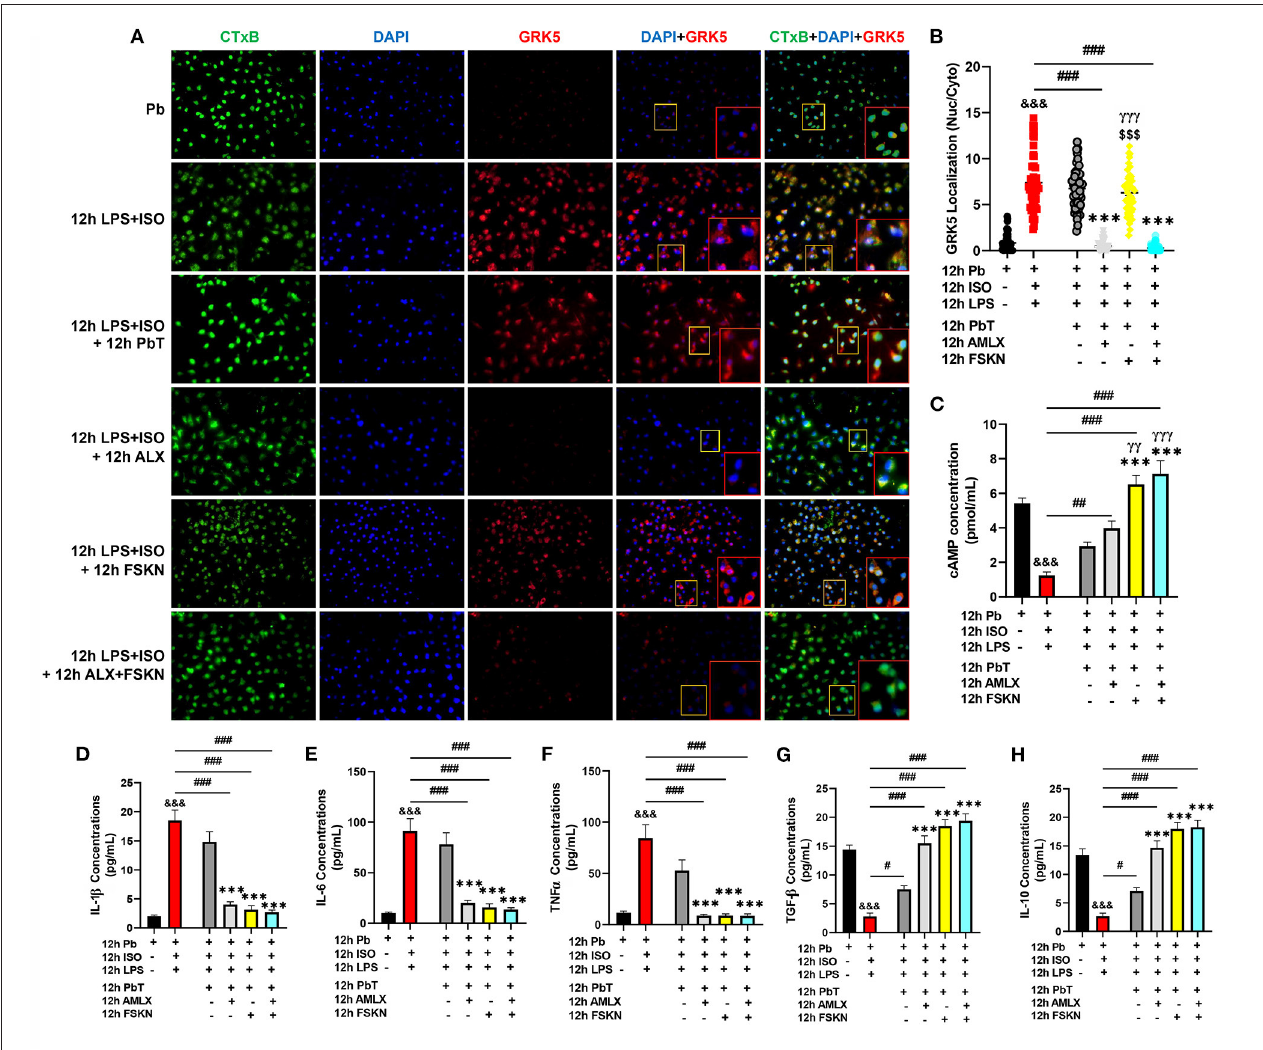
FIGURE 5 | Amlexanox and Forskolin inhibits hyperactive proinflammatory responses via G protein-coupled receptor kinase 5 (GRK5) inhibition and synergistic upregulation of cyclic adenosine monophosphate (cAMP). (A) Representative immunofluorescence of GRK5 localizations, cytoplasmic membrane (CTxB), and nuclei (DAPI). (B) The plotted values are the GRK5 (nuclear/cytoplasm) expression ratios assessed from each PM 8 ( n = 12–15 cells per 4 mice per group). Color channels were adjusted in the merged images to enhance the visualization of all the respective fluorescence dyes. (C) Graphical plots of evaluated cAMP concentrations to assess the effect of the treatment interventions cAMP bioavailability. (D–F) Graphical plots of ELISA evaluated proinflammatory cytokines (IL-1 β , IL-6, and TNF α ) concentrations. (G,H) Graphical presentations of ELISA evaluated anti-inflammatory cytokines (TGF- β and IL-10) concentrations. The sera ELISA were performed in triplicates (n ≥ 1*10 6 cells per 4 mice per group). &&& p < 0.001 vs Pb; # p < 0.05, ## p < 0.01, ### p < 0.001; *** p < 0.001 vs. ICM + PbT; γγ p < 0.01, γγγ p